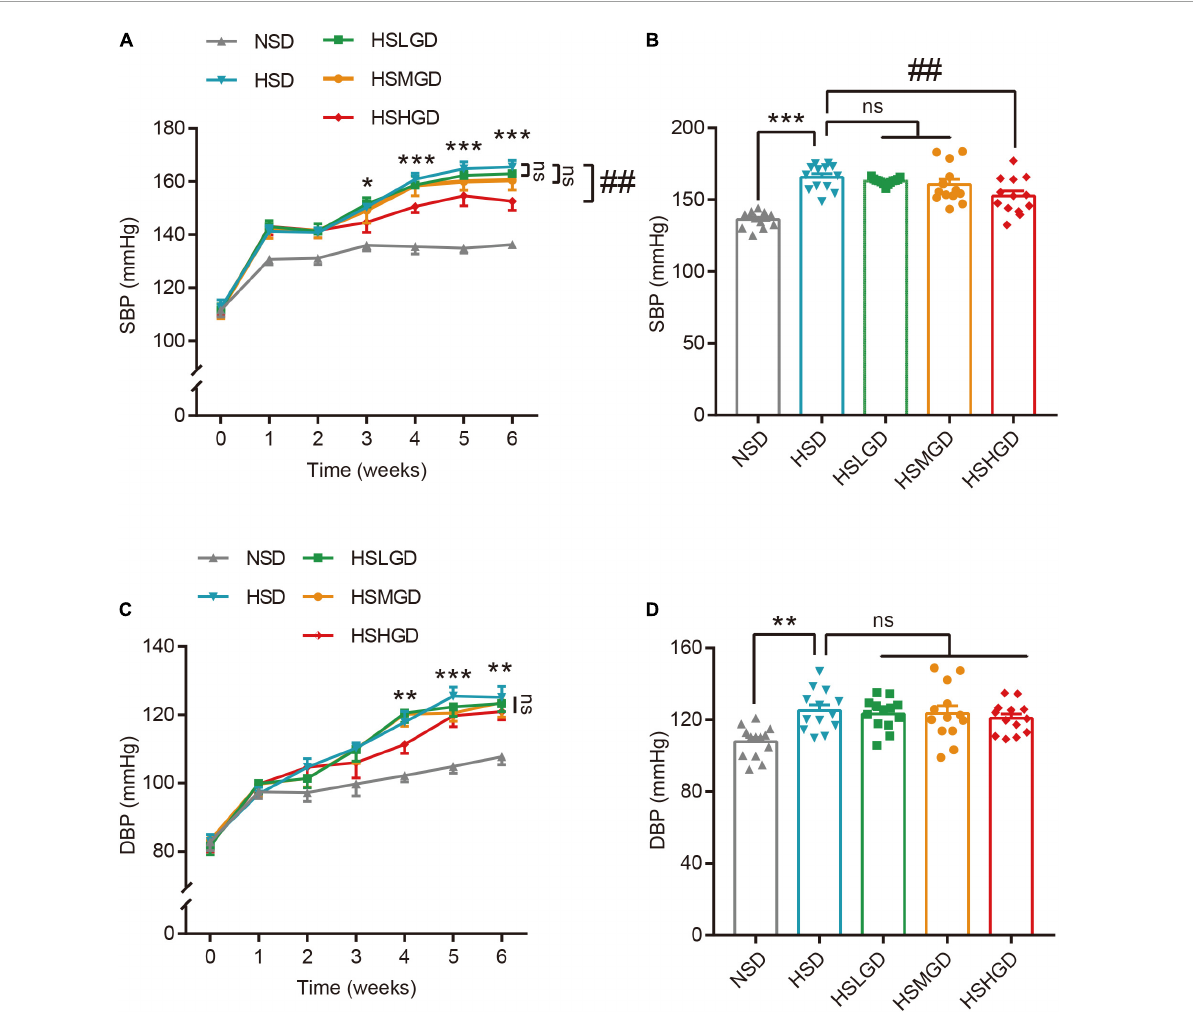
FIGURE2 Effects of dietary glutamine on blood pressure (BP) in salt-induced hypertensive rats. (A,B) Rats were fed on a normal-salt diet (NSD), high-salt diet (HSD), high-salt + low-dose glutamine diet (HSLGD), high-salt + middle-dose glutamine diet (HSMGD), or high-salt + high-dose glutamine diet (HSHGD) for 7 weeks. Systolic blood pressure (SBP) was measured every week by the tail-cuff system. The changes of SBP from 1 to 6 weeks (A) and at 6-week feeding intervention (B) . (C,D) The diastolic blood pressure (DBP) of rats fed on NSD, HSD, HSLGD, HSMGD, or HSHGD from 1 to 6 weeks (C) and at 6-weeks of feeding intervention (D) . n = 13 rats per group. Data are presented as means ± SEM. * P < 0.05, ** P < 0.01, *** P < 0.001, compared with NSD group; ## P < 0.01 compared with HSD group. ns: no significance. One-way ANOVA followed by Bonferroni’s post-hoc test (A–D)